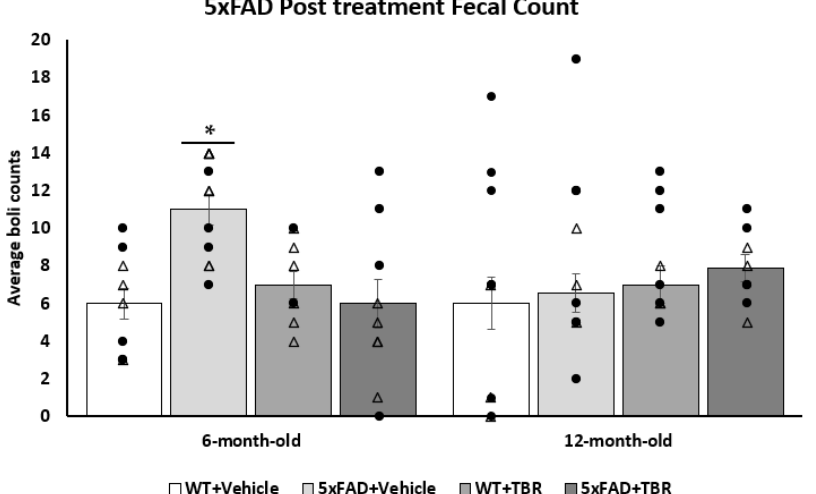
Figure 4. Effect of TBR on fecal boli in 5xFAD mice. Total number of fecal boli count in 6-month-old